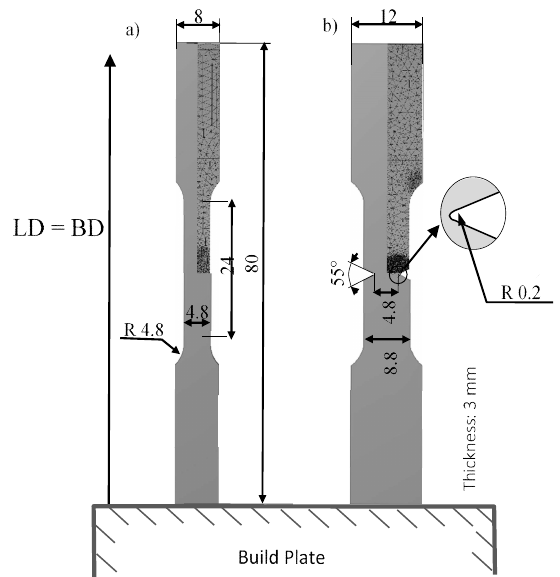
Figure 1. Sketches of the dense specimens: ( a ) plain ( b ) notched; BD and LD correspond to the building and loading directions, respectively; all dimensions are in mm.